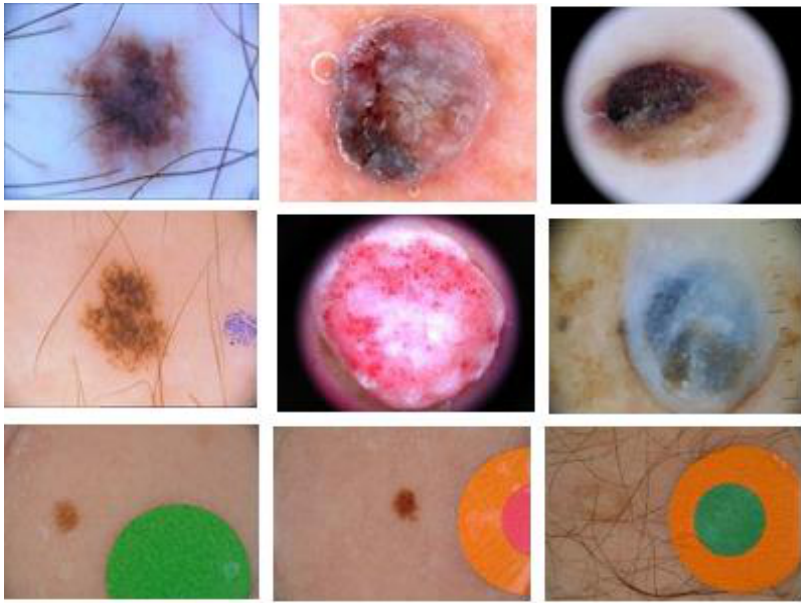
Figure 1. Examples of noise in